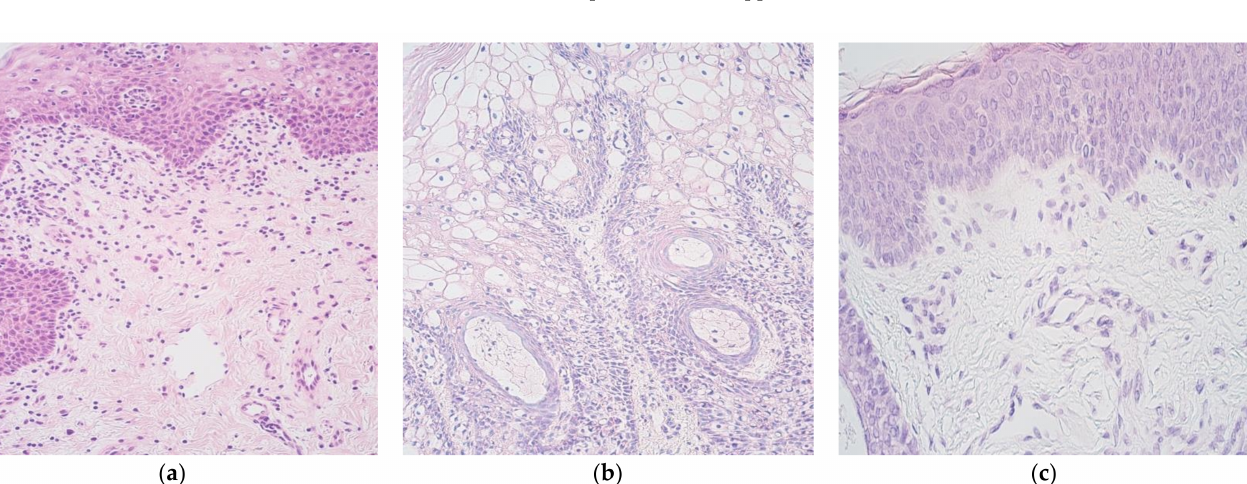
Figure 1. Micrographs of a cleft affected lip tissue. ( a ) Notable inflammation (+++) in the connective tissue and moderate degree of basal cell hyperplasia (++) in the epithelium of a 13 months old child with a cleft lip and palate. Haematoxylin and eosin, × 250; ( b ) Vacuolated cells of seborrheic keratosis of the lip epithelium in a three months old child with a cleft lip and palate. Haematoxylin and eosin, × 250. ( c ) Tissue sample without seborrheic keratosis, inflammation, and basal cell hyperplasia in a four months old child with a cleft lip and palate. Haematoxylin and eosin, × 400.